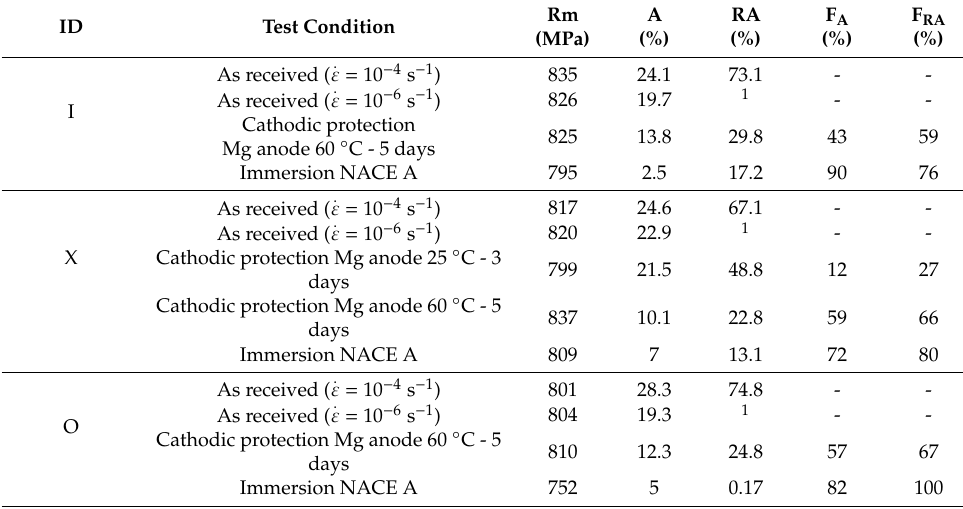
Table 4. SSR test conditions and results.